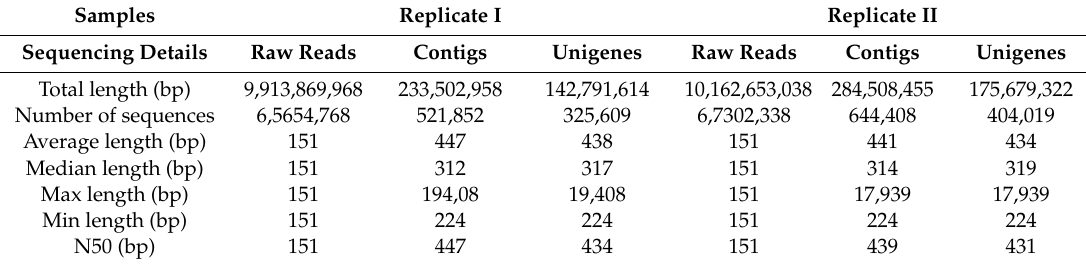
Table 1. Summary of transcriptome of the L. radiata